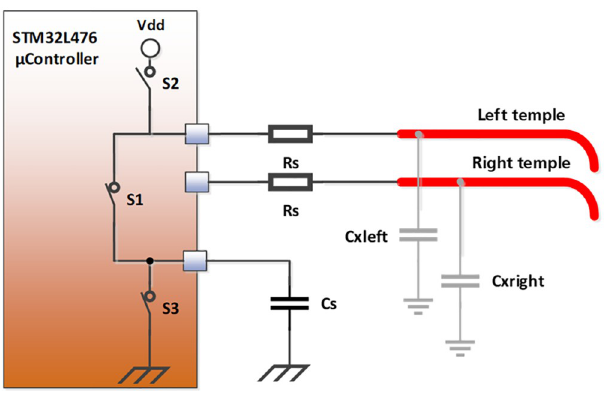
Fig 4. Capacitive sensing principle for the state of wear position